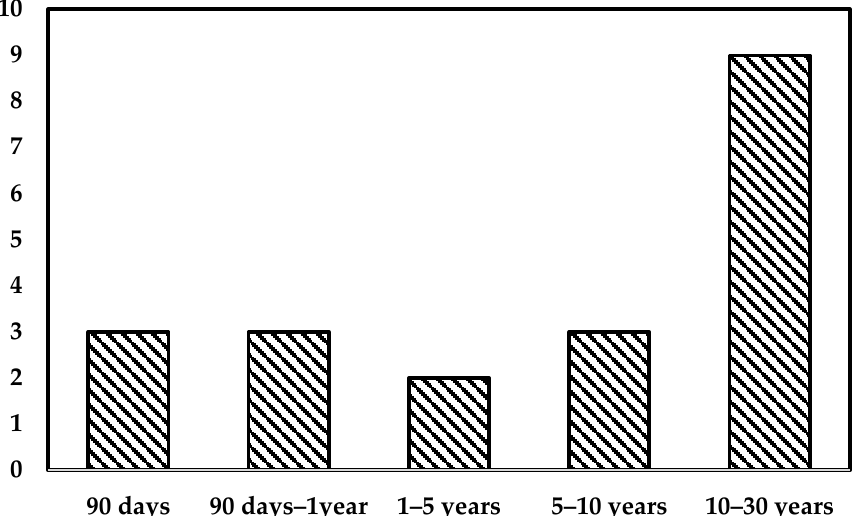
Figure 1. Time-dependent mortality post transplantation ( n = 19, 41%).During the study period, 19 (41%) patients died between ten days and 24 years after transplantation. In three cases, death oc- curred within 90 days of transplantation: one patient suffered from multi-organ system failure sec- ondary to sinusoidal obstruction syndrome ten days after the initial transplantation; two patients died within eleven and 22 days after transplantation due to multi organ failure and perioperative hemorrhage, respectively. Figure 2 displays patient and graft survival of the BCS cohort.